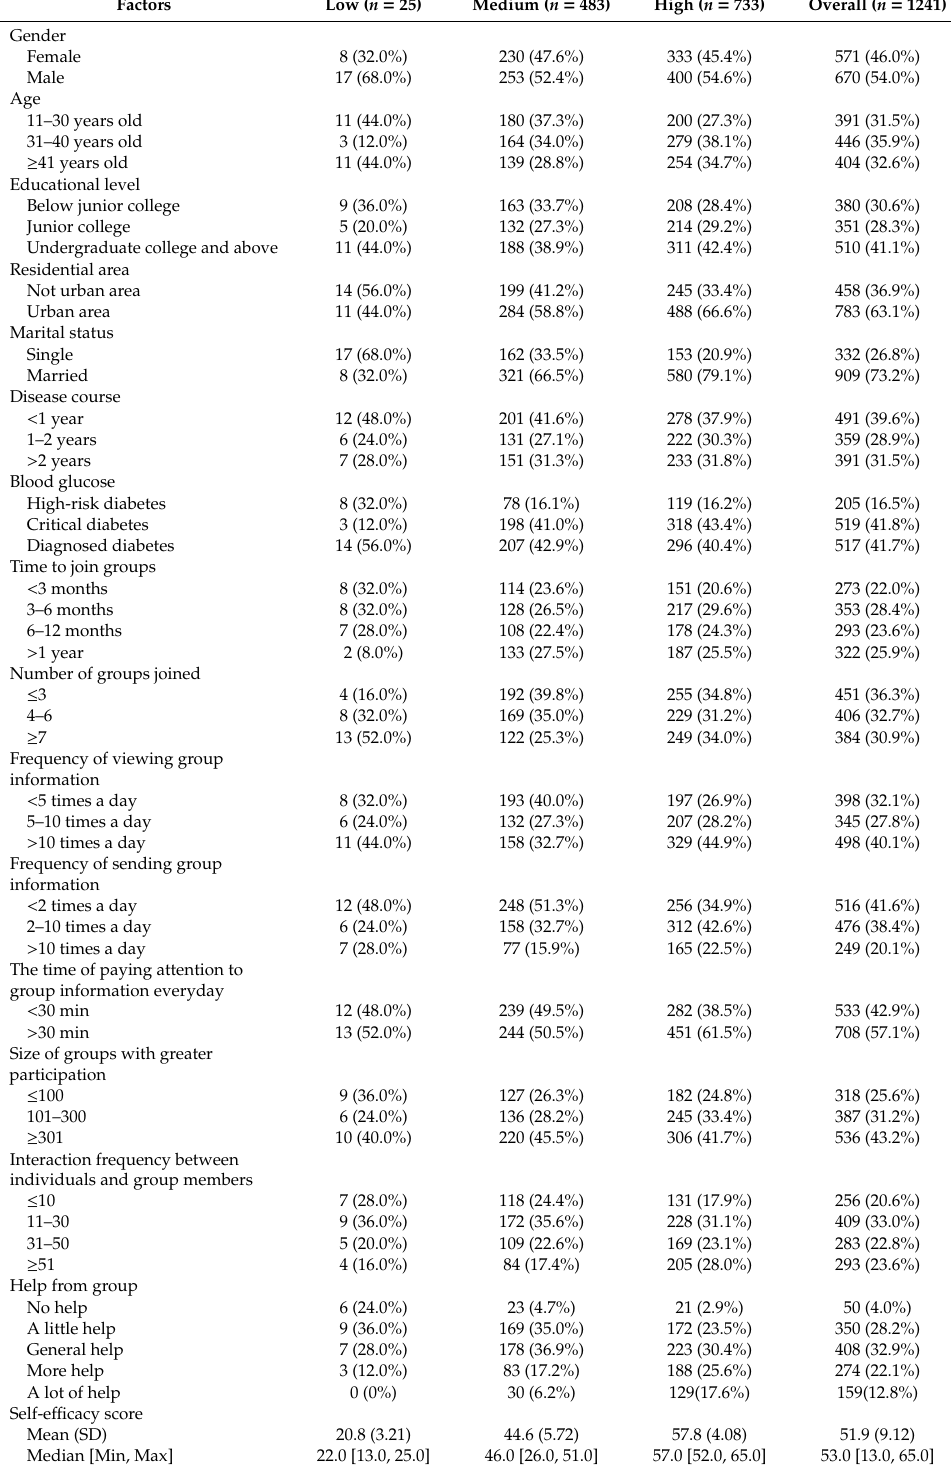
Table 1. The demographic characteristics and online participation of the